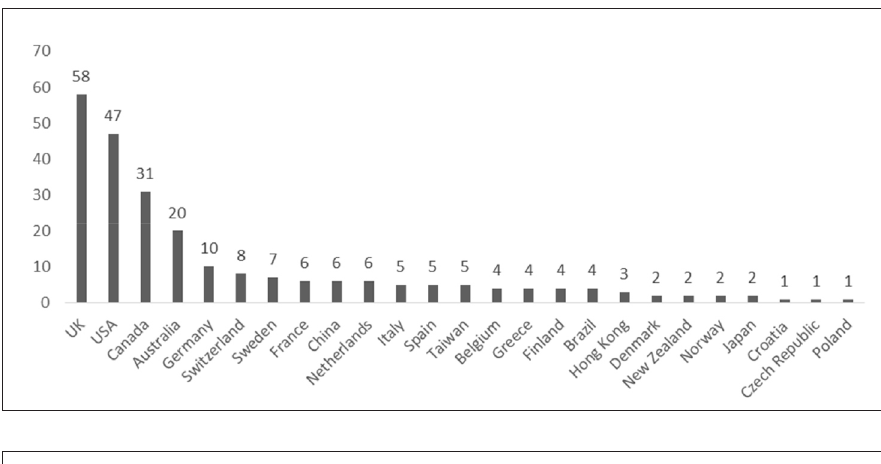
Figure 2. Top 25 contributing countries (the number of first authors affiliated to a certain country in the